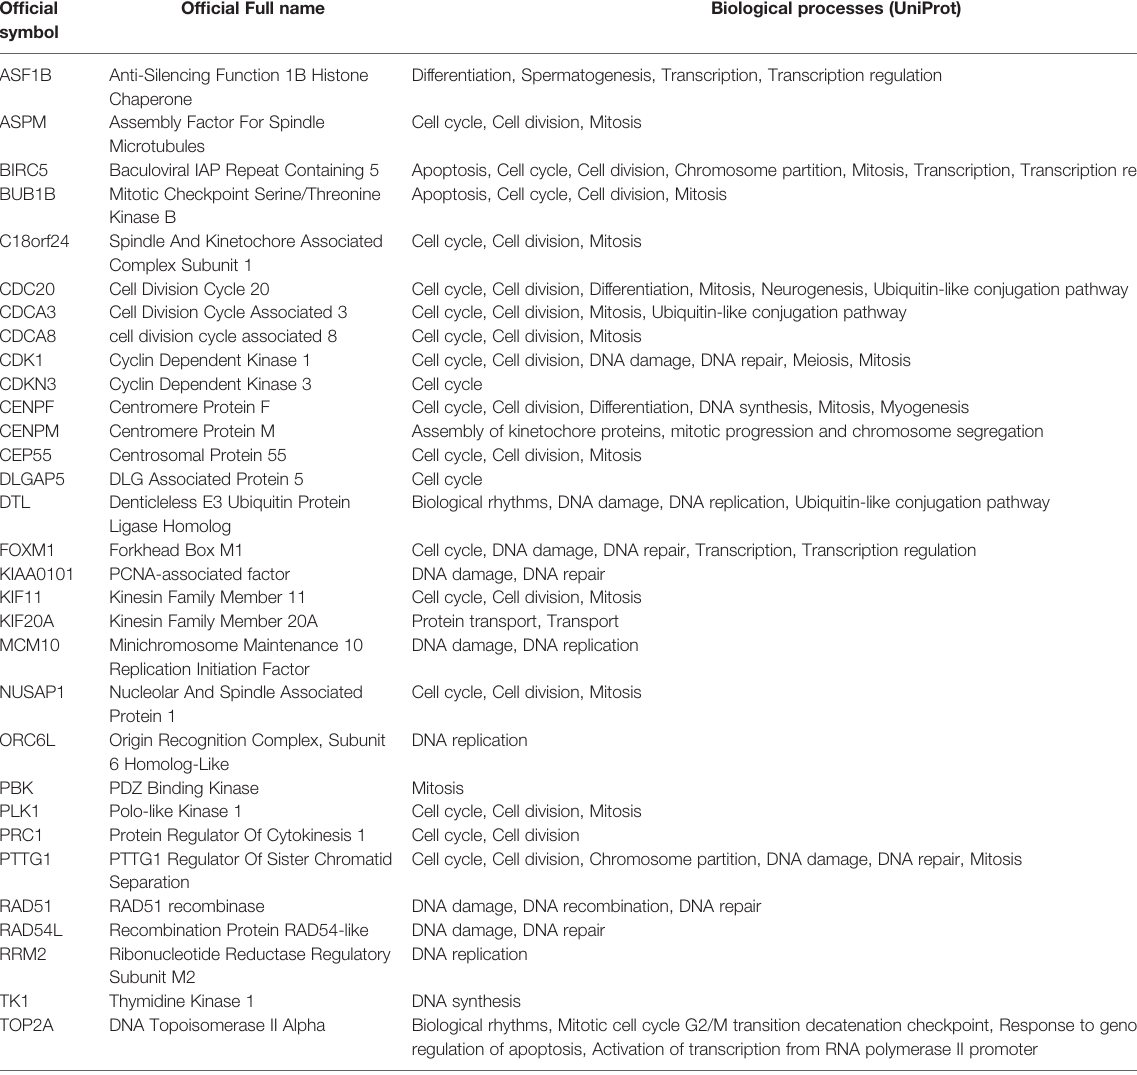
TABLE 1 | List of target genes and associated biological processes. Of fi cial Of fi cial Full symbol